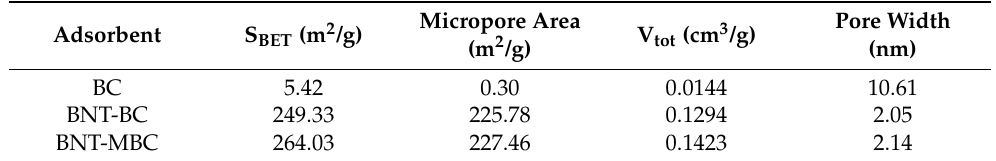
Table 1. Pore structure analysis of BC, BNT-BC, and BNT-MBC.